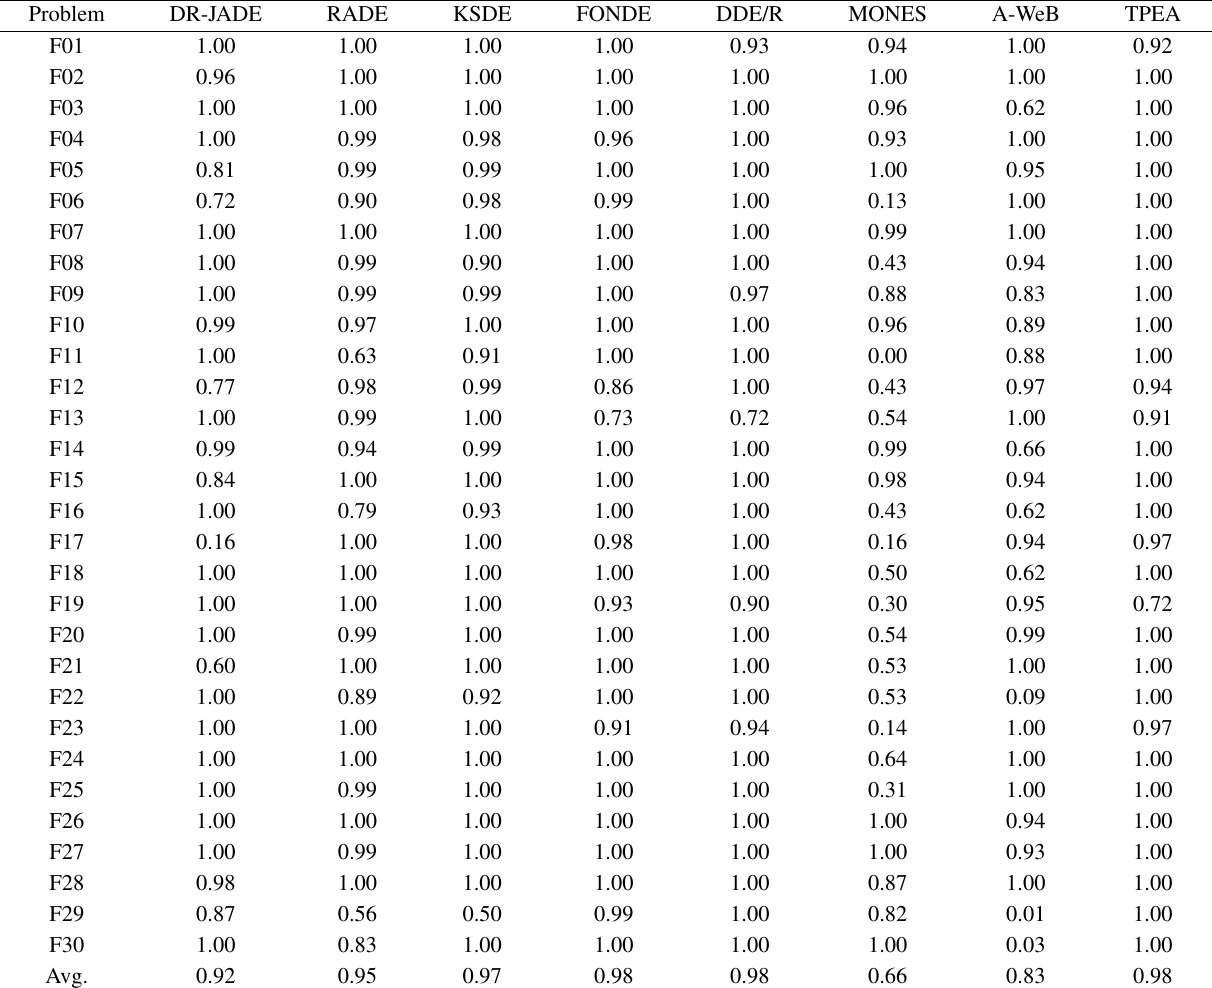
Table 3 Comparison of root ratio with respect to different intelligent optimization